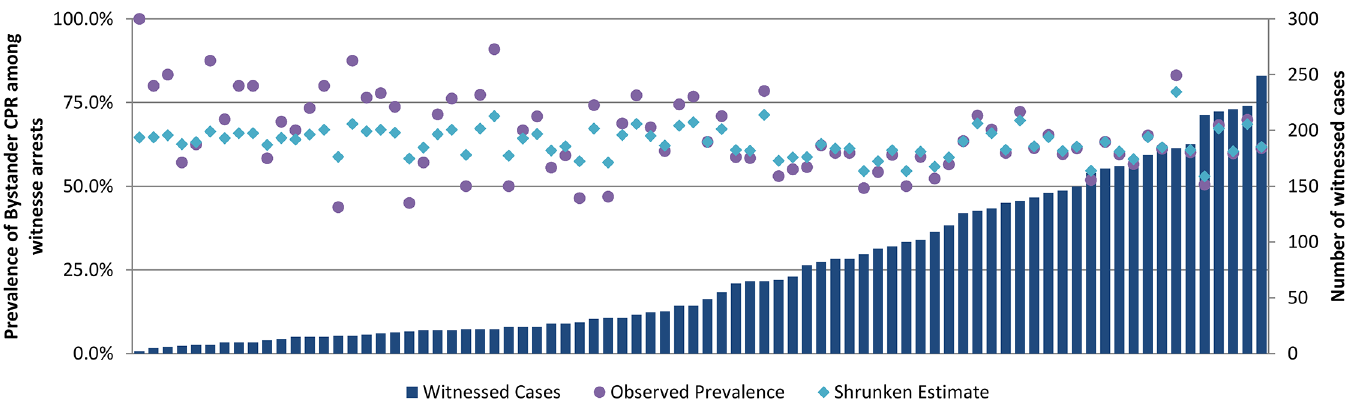
Fig 3. Bystander witnessed OHCA cases by Victorian Local Government Area with the Observed Prevalence and shrunken estimate of Bystander CPR among witnessed arrests, 2008 – 2013.